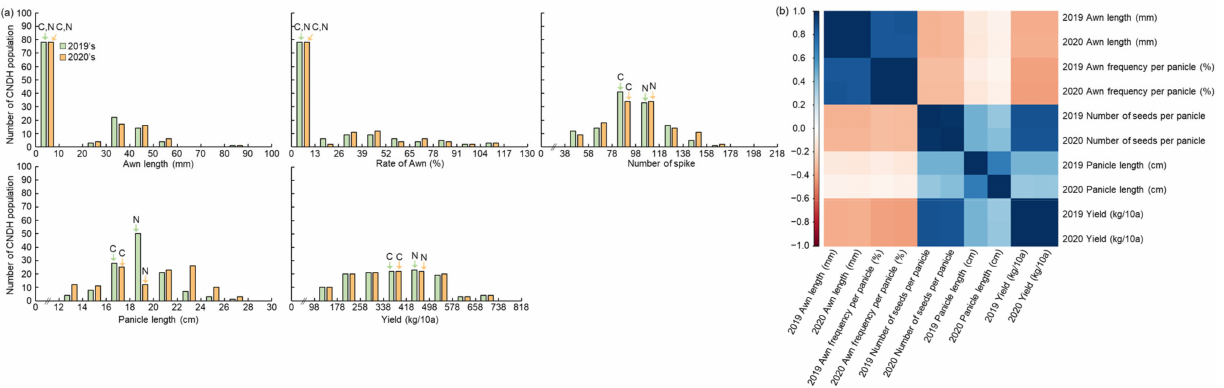
Figure 2. Frequency distribution and heat map for agricultural traits. ( a ) Frequency distribution for awn development traits in the CNDH population. All agricultural traits, such as awn length, awn frequency per panicle, number of seeds per panicle, panicle length, and yield, of the CNDH population were of normal distribution. Therefore, awn development is regulated by quantitative traits. C, Cheongcheong; N, Nagdong. ( b ) Heat map showing the correlation matrix for agricultural traits related to awn development. The color corresponds to the strength of correlations (blue, positive correlation; white, no correlation; red, negative correlation). Awn length and awn frequency per panicle have a very high level of positive correlation, and awn length and yield have a very high level of negative